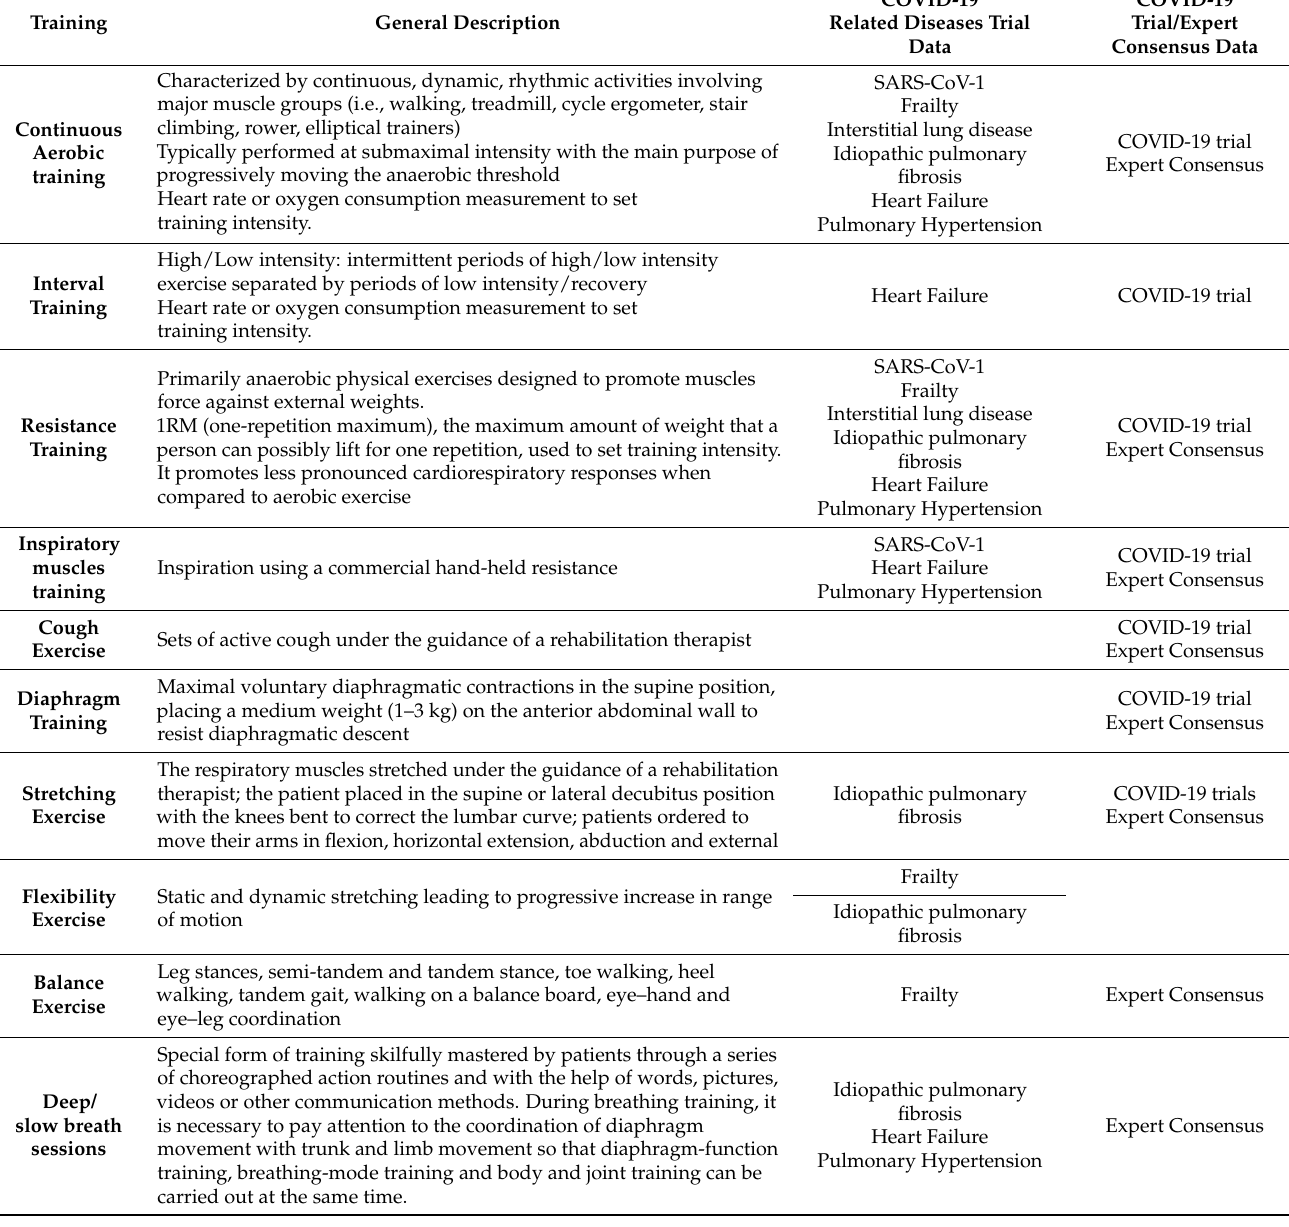
Table 3. Different exercise training programs with a general description, COVID-19 related diseases trial data and COVID-19 trial/Expert Consensus